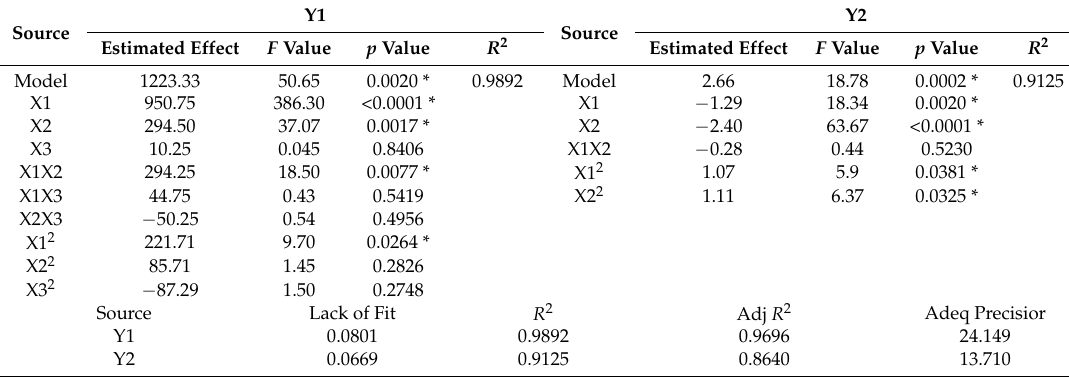
Table 3. ANOVA for quadratic model hydrogel properties of felbinac